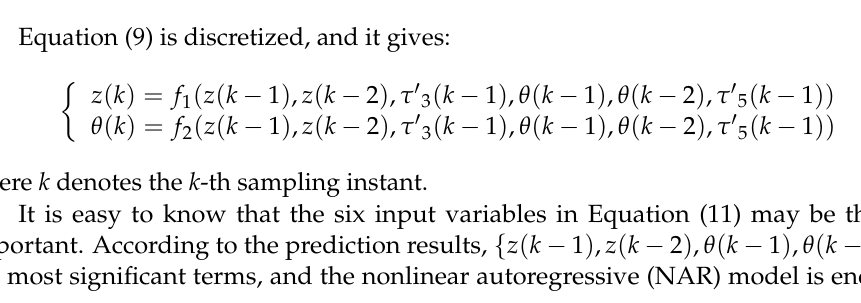
Figure 3. The coupled heave-pitch motions of the R-Class Icebreaker model in irregular waves. Equation (9) is discretized, and it